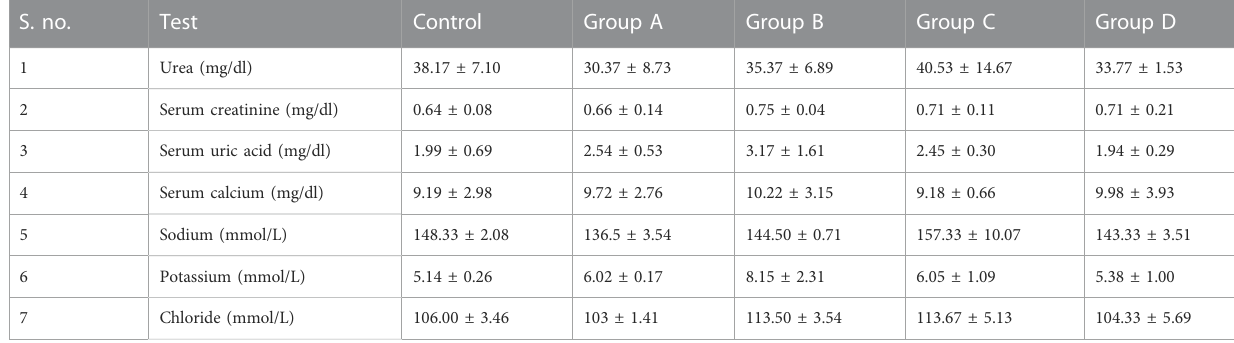
TABLE 4 Kidney function parameters in rats after 14 days of oral NVA-IT administration. S.